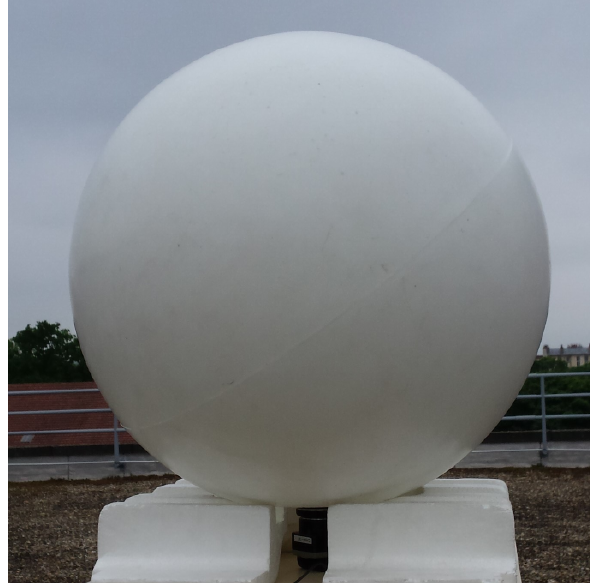
Figure 13. Implementation of flat-field calibration using the spherical diffuser.